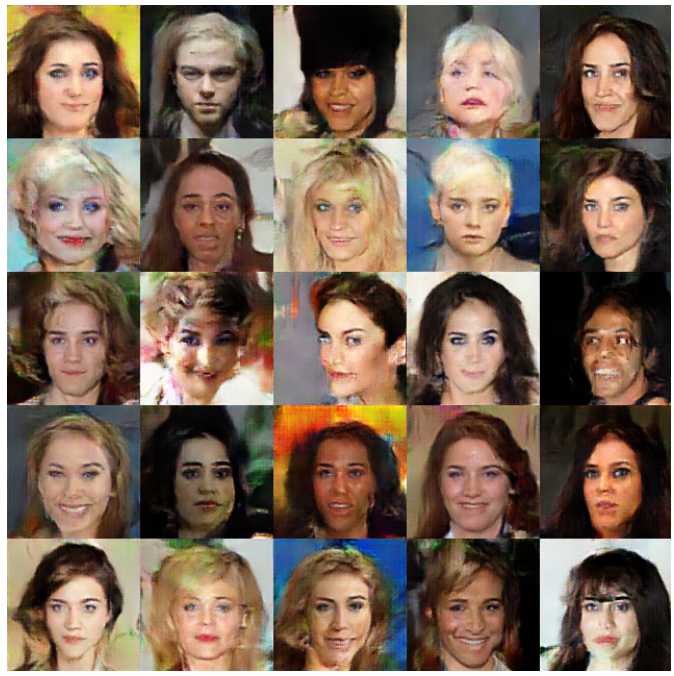
Figure 4. Difficulty in high-resolution data